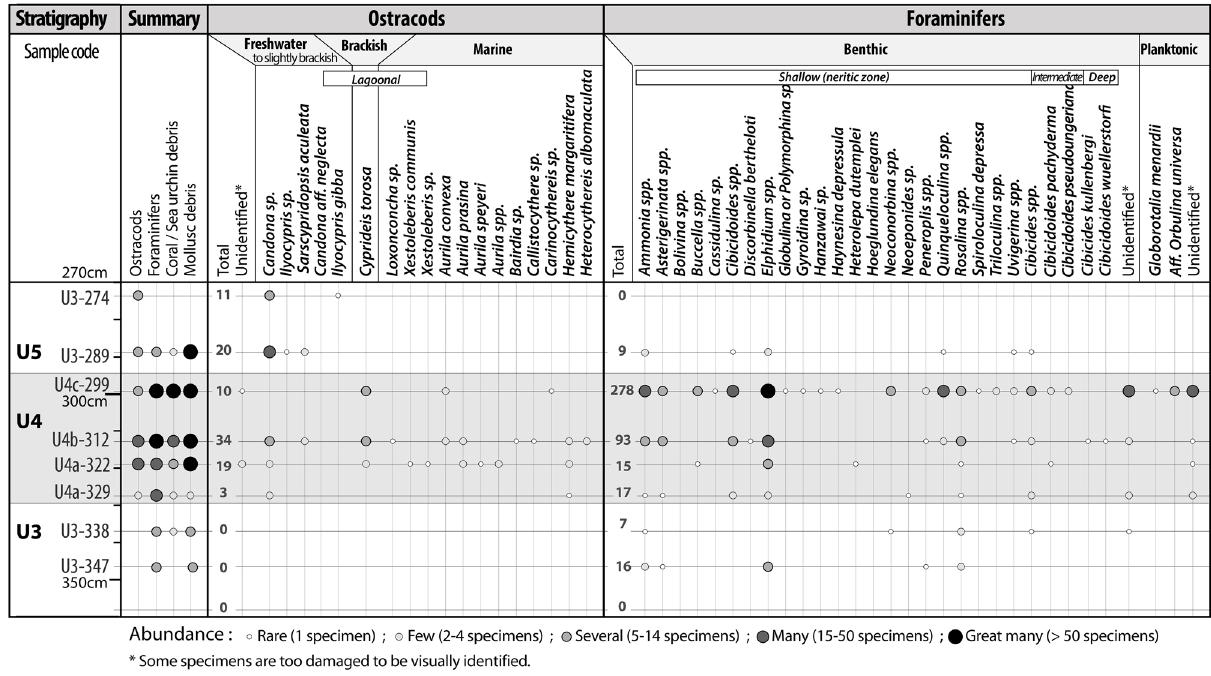
Figure 6. Microfaunal content of samples in C21